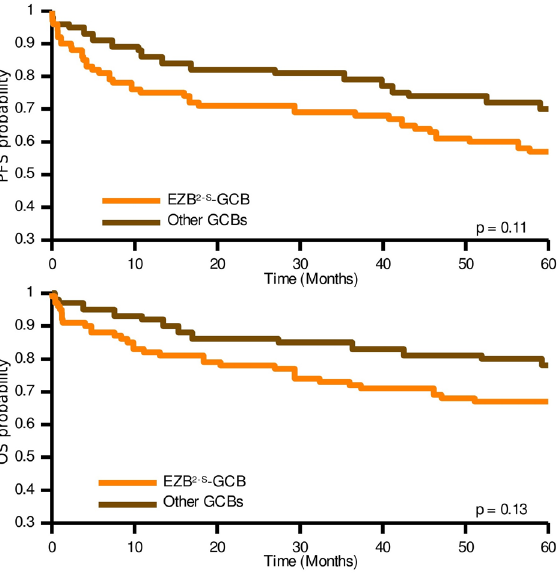
Figure 6. Kaplan–Meier analysis of progression-free survival (PFS) and overall survival (OS) for EZB 2-S -GCB and other GCB cases in the HMRN cohort when applying the two-step